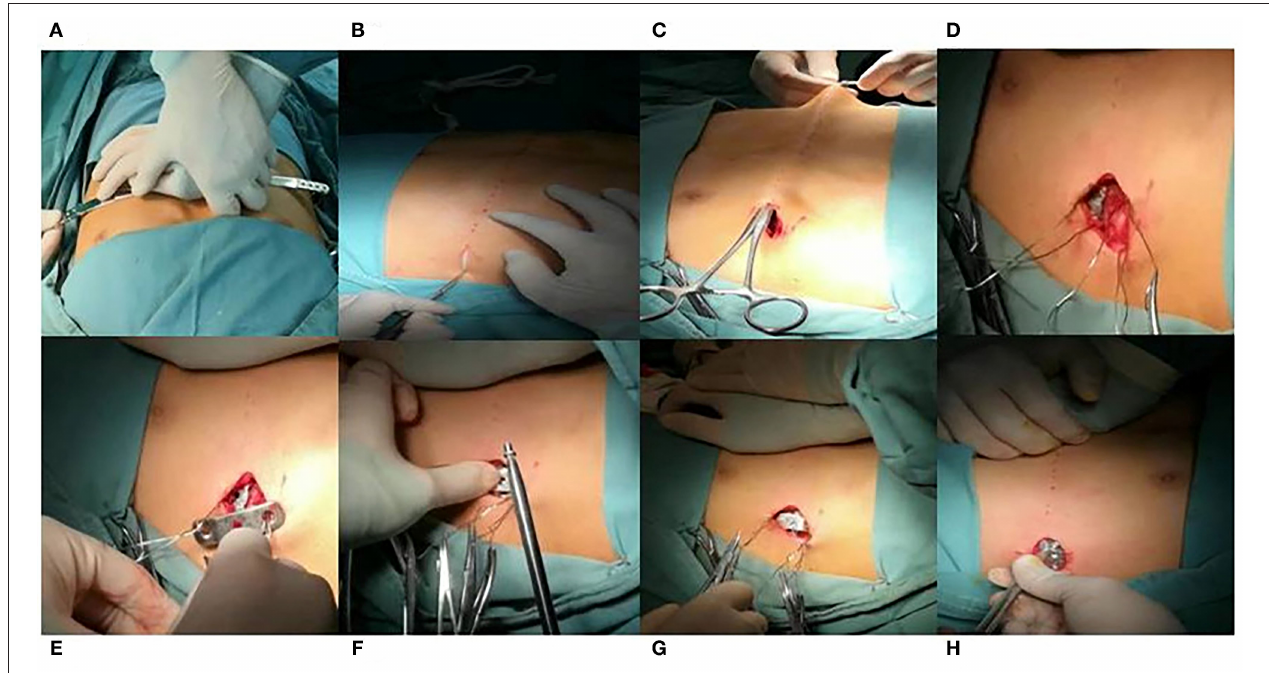
FIGURE 2 | Modified procedure for pectus carinatum. (A) Press the highest point of the sternum to make the profile of the chest wall as normal so as to measure the length between two sides of the incision with a long rope, whose length was the same as the steel plate we used in the operation. (B) The vertical incision along the midaxillary line was adopted. (C) Build a subcutaneous tunnel with the help of a oval forceps tied by a long rope which is reserved through the subcutaneous tunnel. (D) Upper and lower ribs of each surgical incision are sutured with two steel wires. (E) One of the steel wires of each side is placed in the hole of the locking piece for later use. (F) Place the fixing screw after aligning the fixing piece against the joint of steel bar with the screw hole. (G) The fixing piece was also fastened to the adjacent two ribs with steel wires. (H) If the thorax shape is not satisfactory, the degree of sedimentation of the chest wall could be adjusted through the lateral hole of the plate to achieve the best corrected shape.